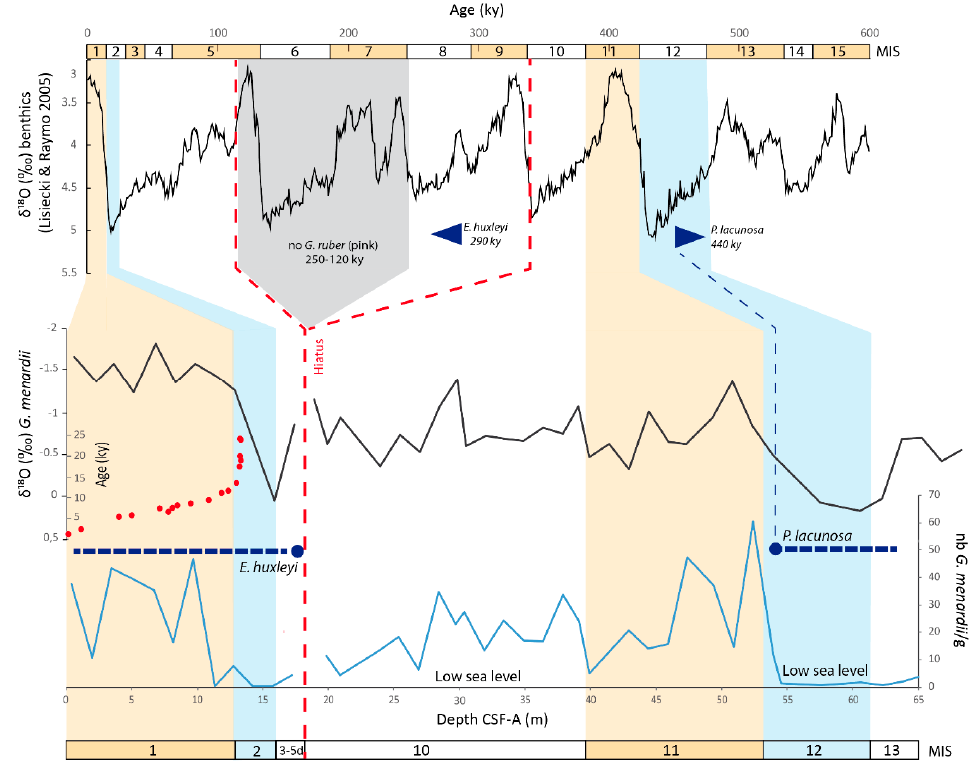
Figure 2. Age model for Site U1461. This age model is based on 14 C radiocarbon dates (represented by red dots) [45] and δ 18 O measurements on Globorotalia menardii as well as the abundance of G. menardii (expressed as individuals per gram of sediment). The reference curve for δ 18 O is measured on benthic foraminifera [47] .